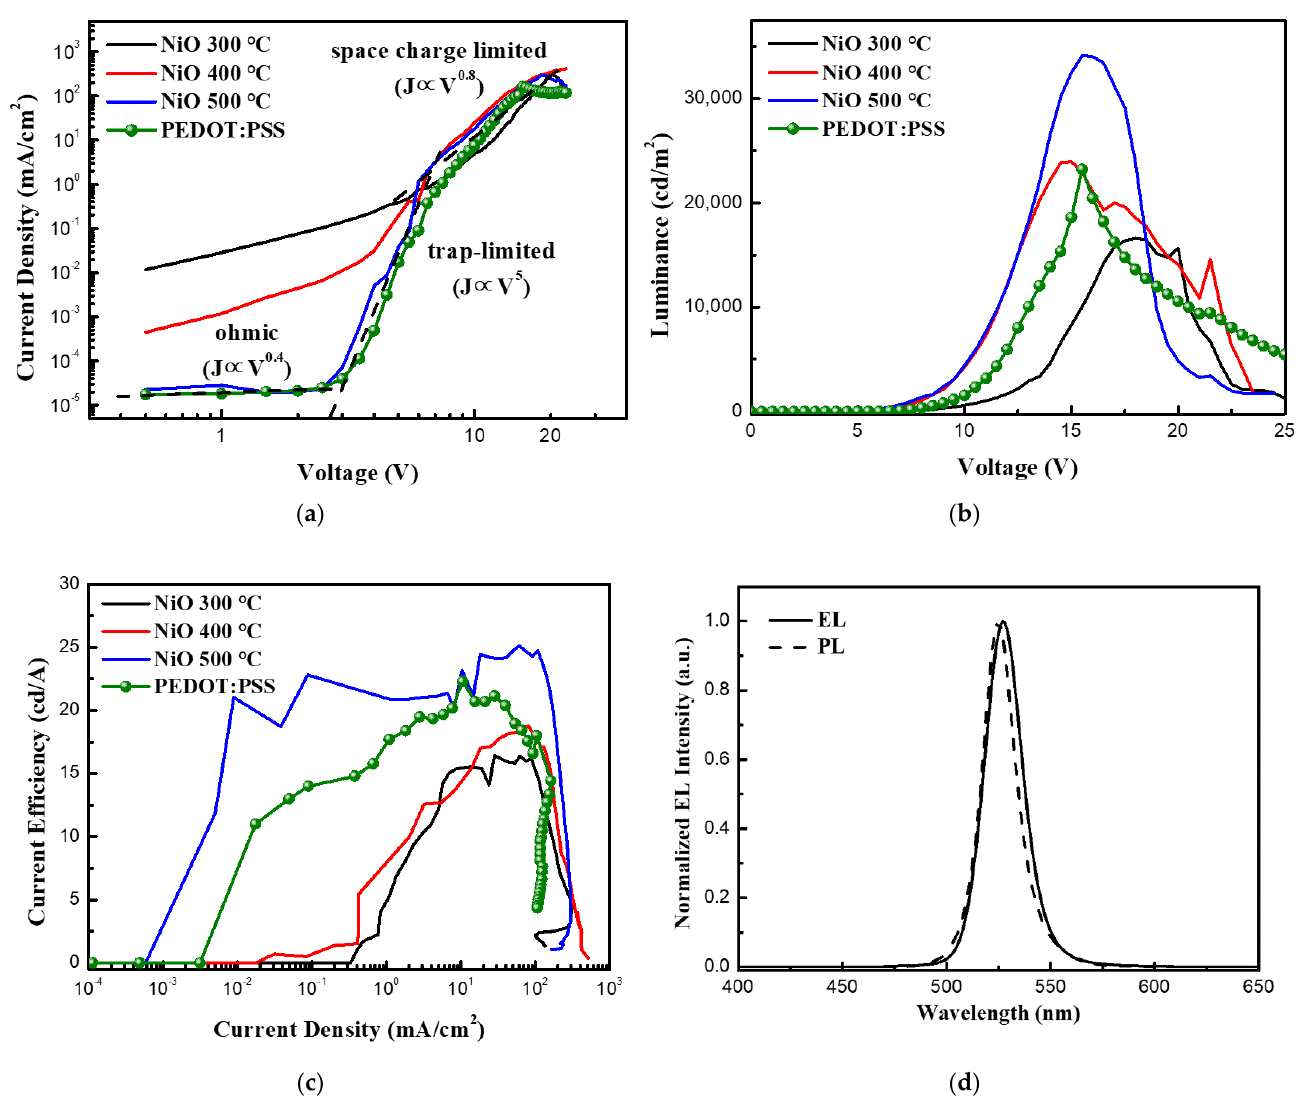
Figure 5. ( a ) Current density–voltage, ( b ) luminance–voltage, and ( c ) current efficiency–current density characteristics of QLEDs with the NiO at different annealing temperatures; ( d ) spectral comparison of PL of a dilute QD dispersion with EL of the device at 10 V.